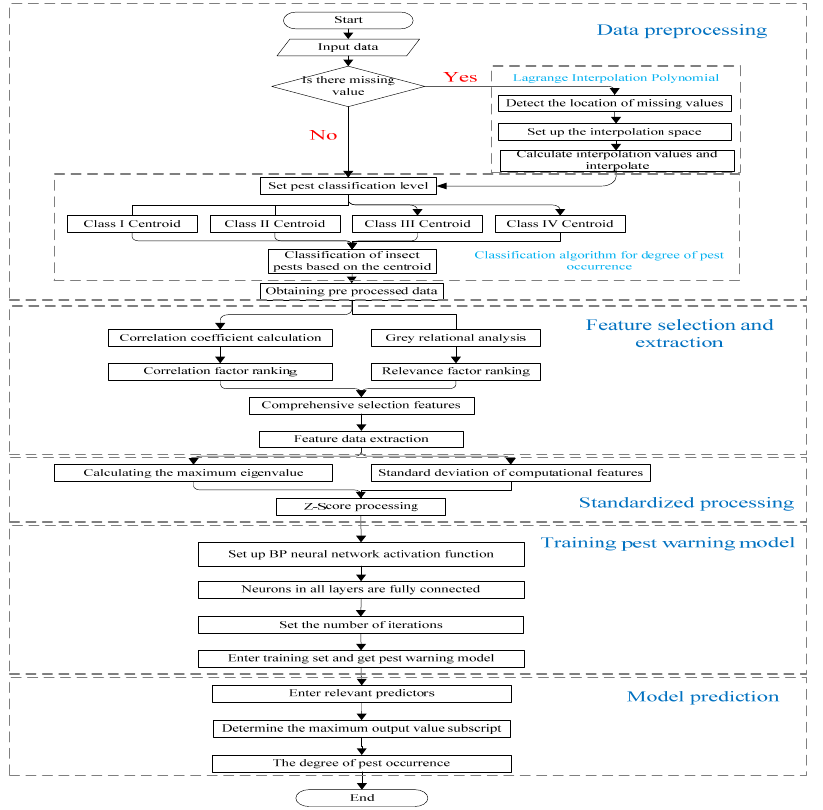
Figure 2. VPWS - MBD design flow chart.